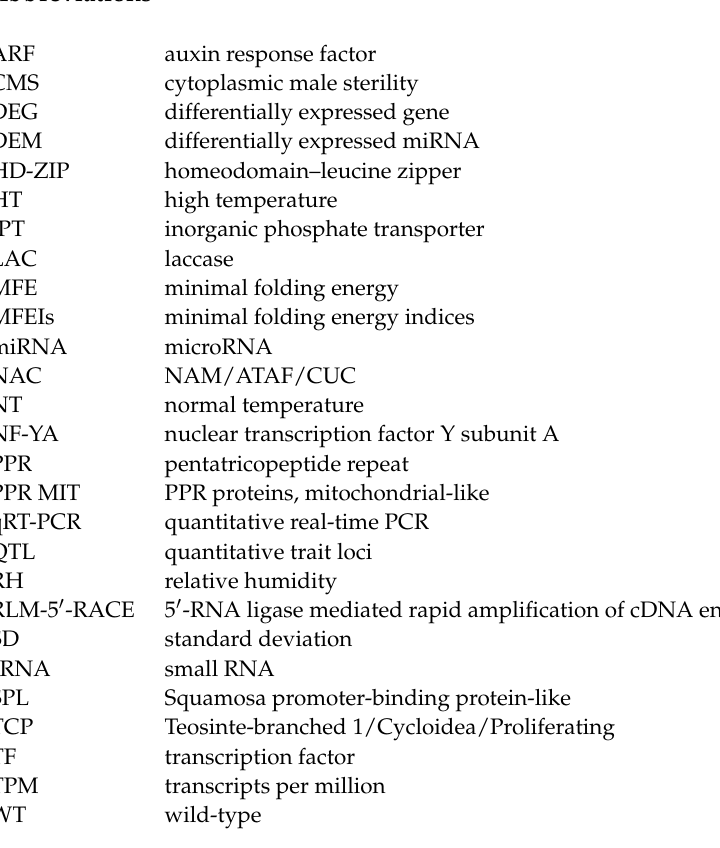
Table S7: The predicted targets of miRNAs identified in flower bud of soybean CMS-based F 1 under HT stress; Table S8: Primers used in this